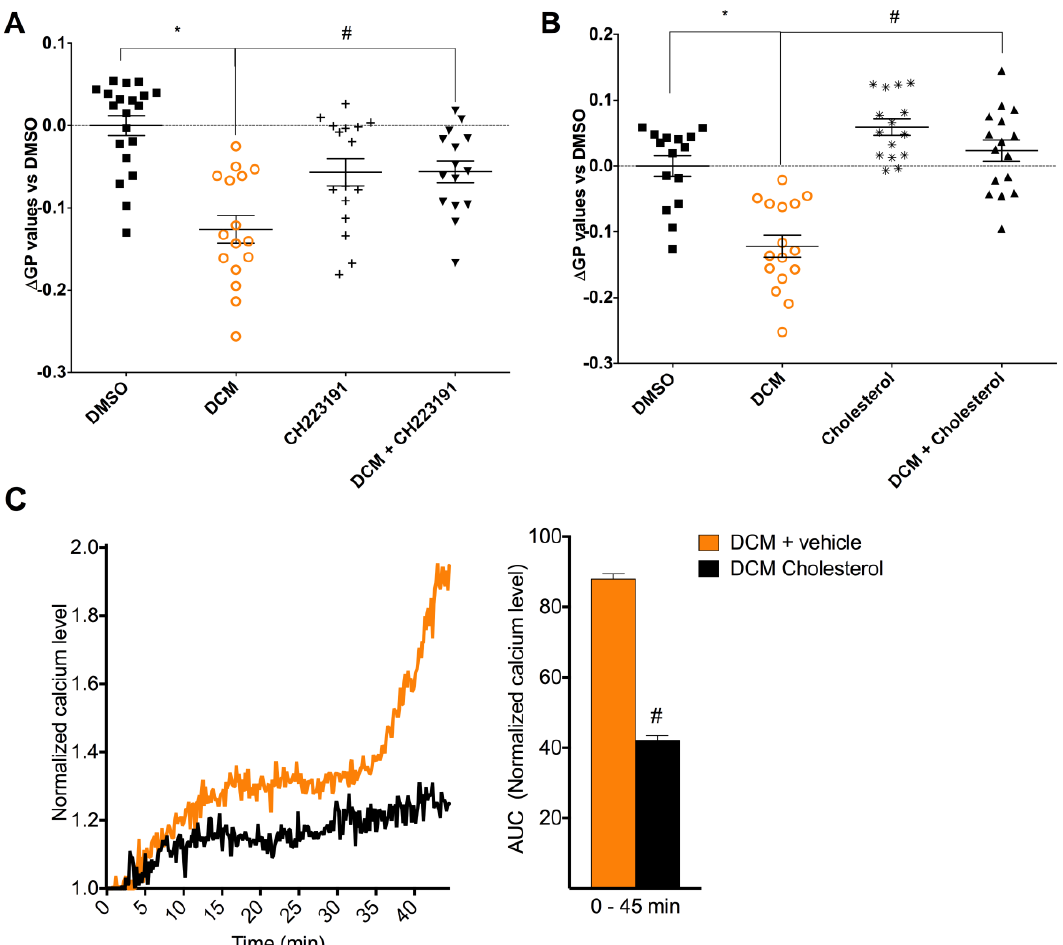
Figure 7. Effects of AhR inhibition and cholesterol on DCM-EOM-induced effects on membrane- microstructure and effect of cholesterol on DCM-EOM induced [Ca 2+ ] i . Cells were incubated in medium with or without the AhR inhibitor (1 µ M CH223191) ( A ) or cholesterol ( B , C ) 30 min prior to exposure. Cells were exposed to DCM-EOM (5 µ g/mL) or vehicle control (DMSO). After 30 min exposure, cells were fixed and stained for lipid membrane order with the fluorescence dye di-4-ANEPPDHQ ( A , B ). Confocal image of HMEC-1 cells stained with di-4-ANEPPDHQ, representative for three experiments. [Ca 2+ ] i levels measured by normalized ratio of the Fura2-AM probe during exposure are presented as a graph and AUC from 1.0 at the Y-axis and 0–45 min ( C ). The results are expressed as mean ± SEM ( n = 3). * Significant difference from DMSO ( p < 0.05). # Significant difference from DCM-EOM ( p < 0.05).